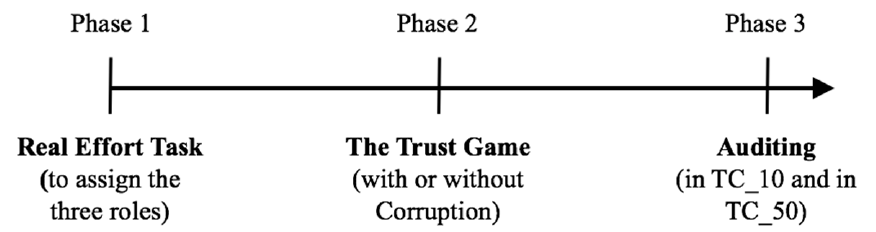
Figure 2. Timeline of the experiment.